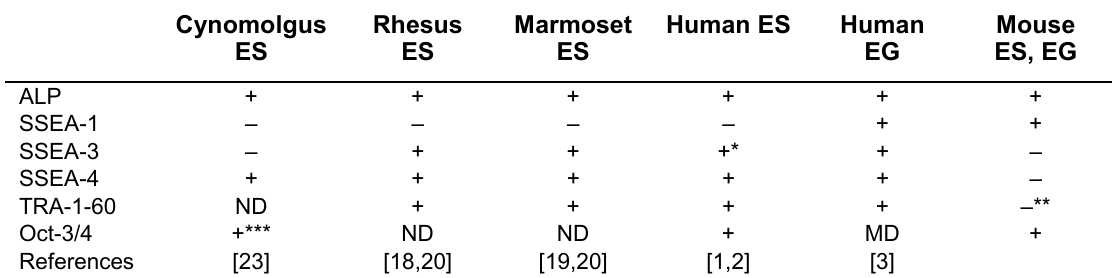
Expression of Various Stem Cell Markers by Monkey ES Cells, Human ES and EG Cells, and Mouse ES and EG